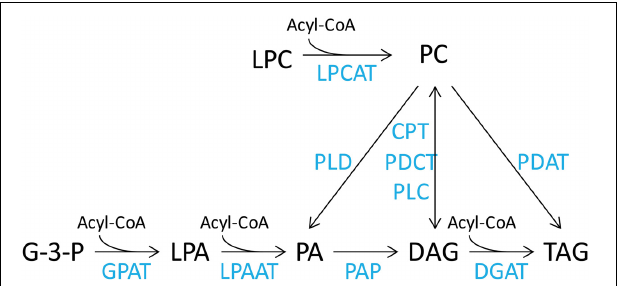
FIGURE 1 | Simplified representation of lipid metabolism in plant cells. Lipid pools are acyl-CoA, acyl co-enzyme A; LPC, lysophosphatidylcholine; PC, phosphatidylcholine; G-3-P, glycerol-3-phosphate; LPA, lysophosphatidic acid; PA, phosphatidic acid; DAG, diacylglycerol; TAG, triacylglycerol. The enzymes are LPCAT, lysophosphatidylcholine acyltransferase; PLD, phospholipase D; CPT, CDP-choline:diacylglycerol cholinephosphotransferase; PDCT, phosphatidylcholine:diacylglycerol cholinephosphotransferase; PLC, phospholipase C; PDAT, phospholipid:diacylglycerol acyltransferase; GPAT, glycerol-3-phosphate acyltransferase; LPAAT, lysophosphatidic acid acyltransferase; PAP, phosphatidic acid phosphatase; DGAT, diacylglycerol